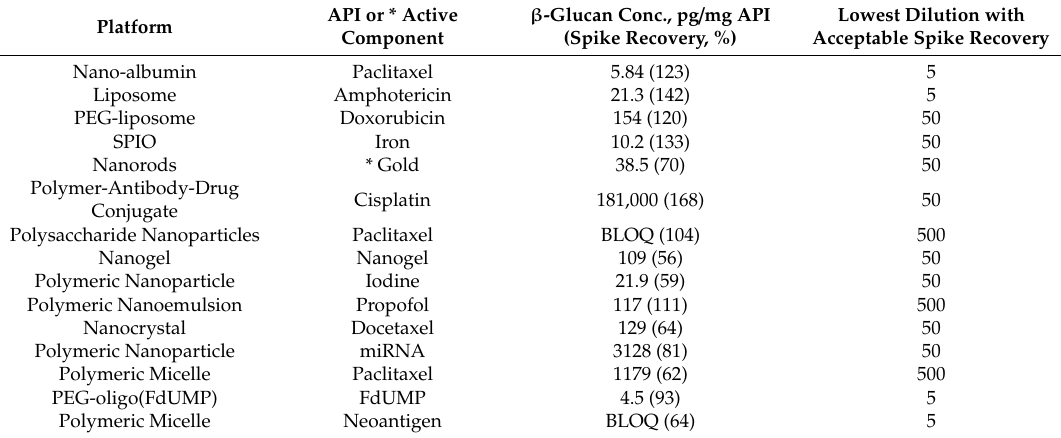
Table 4. Levels of beta-glucans in various formulations . Three dilutions (5, 50, and 500-fold) of the stock nanomaterial were prepared in pyrogen-free water for all formulations and tested with the commercial factor-C-depleted LAL assay (Glucatell ® ) using the procedure detailed in https: // ncl.cancer.gov / sites / default / files / protocols / NCL_Method_STE-4.pdf. The results were normalized to provide beta-glucan levels in picograms per milligram of active pharmaceutical ingredient (API). The spike recovery and inhibition / enhancement control (IEC) requirements for the LAL assay were used to evaluate the performance of the Glucatell assay. The IECs were prepared by spiking a known concentration of beta-glucan standard into the test sample at each dilution. A recovery of 50–200% was considered acceptable, whereas recovery outside of this range suggested nanoparticle interference; consequently, the data from dilutions demonstrating unacceptable spike recovery were considered invalid and excluded from the analysis. The data presented are from the lowest dilution that did not interfere with the assay. BLOQ = below the assay lower limit of quantification (undetectable); SPIO = superparamagnetic iron oxide; PEG = poly(ethylene